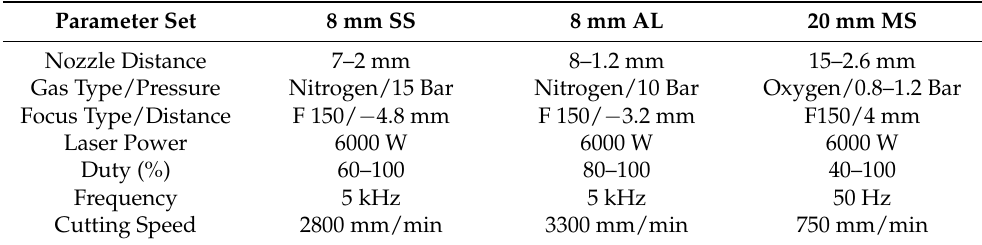
Table 4. Example piercing and cutting parameter set used in 6 kW tests.